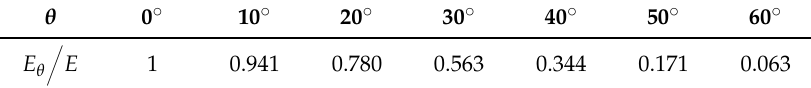
Table 1. Illuminance ratio of image points off and on axis with different field